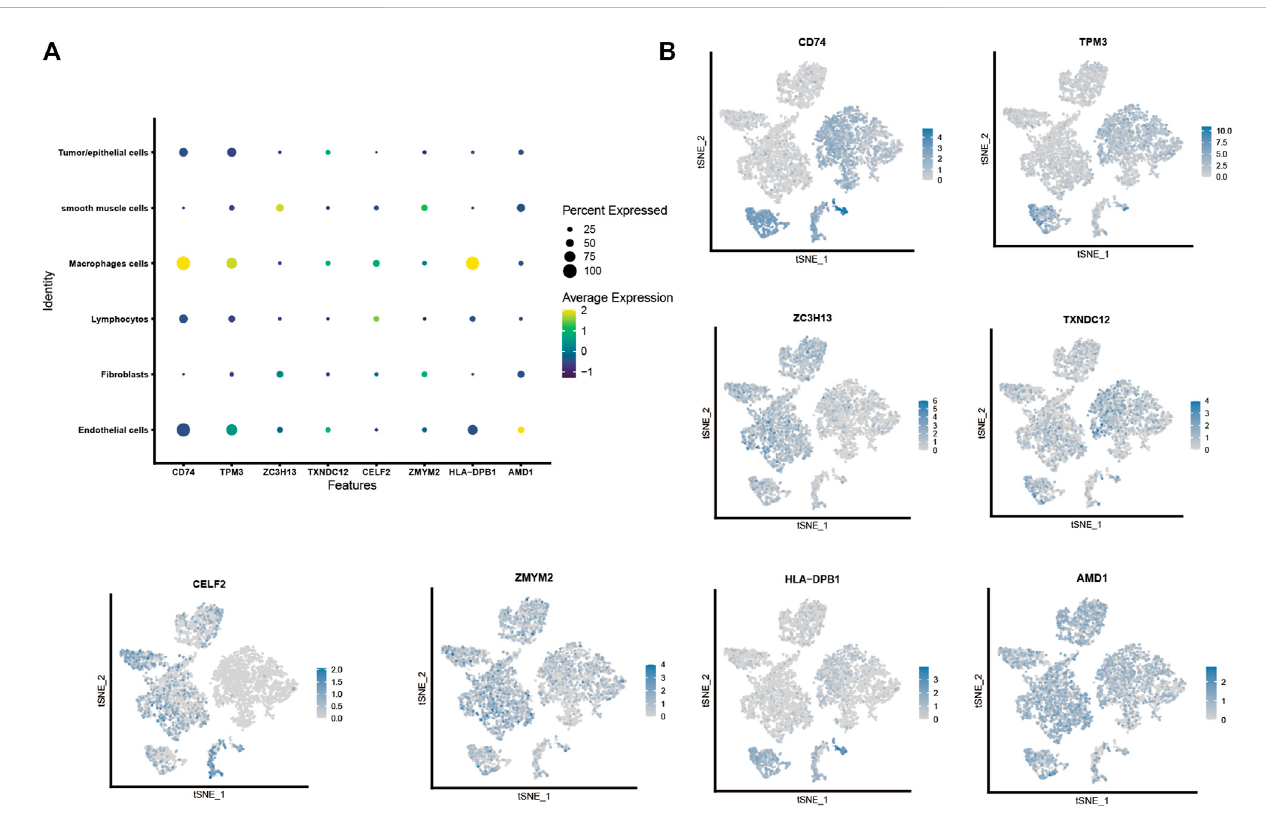
FIGURE 5 Cell localization of eight modeling genes in the single-cell sequencing dataset. (A,B) . Distribution and expression of eight prognostic modeling genes in six type of